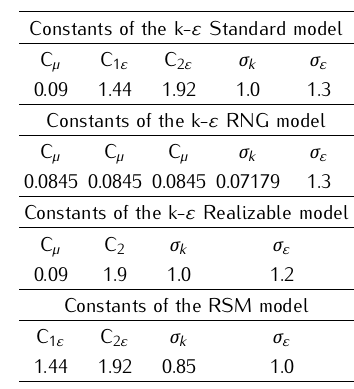
Table 1. Constants of the turbulente